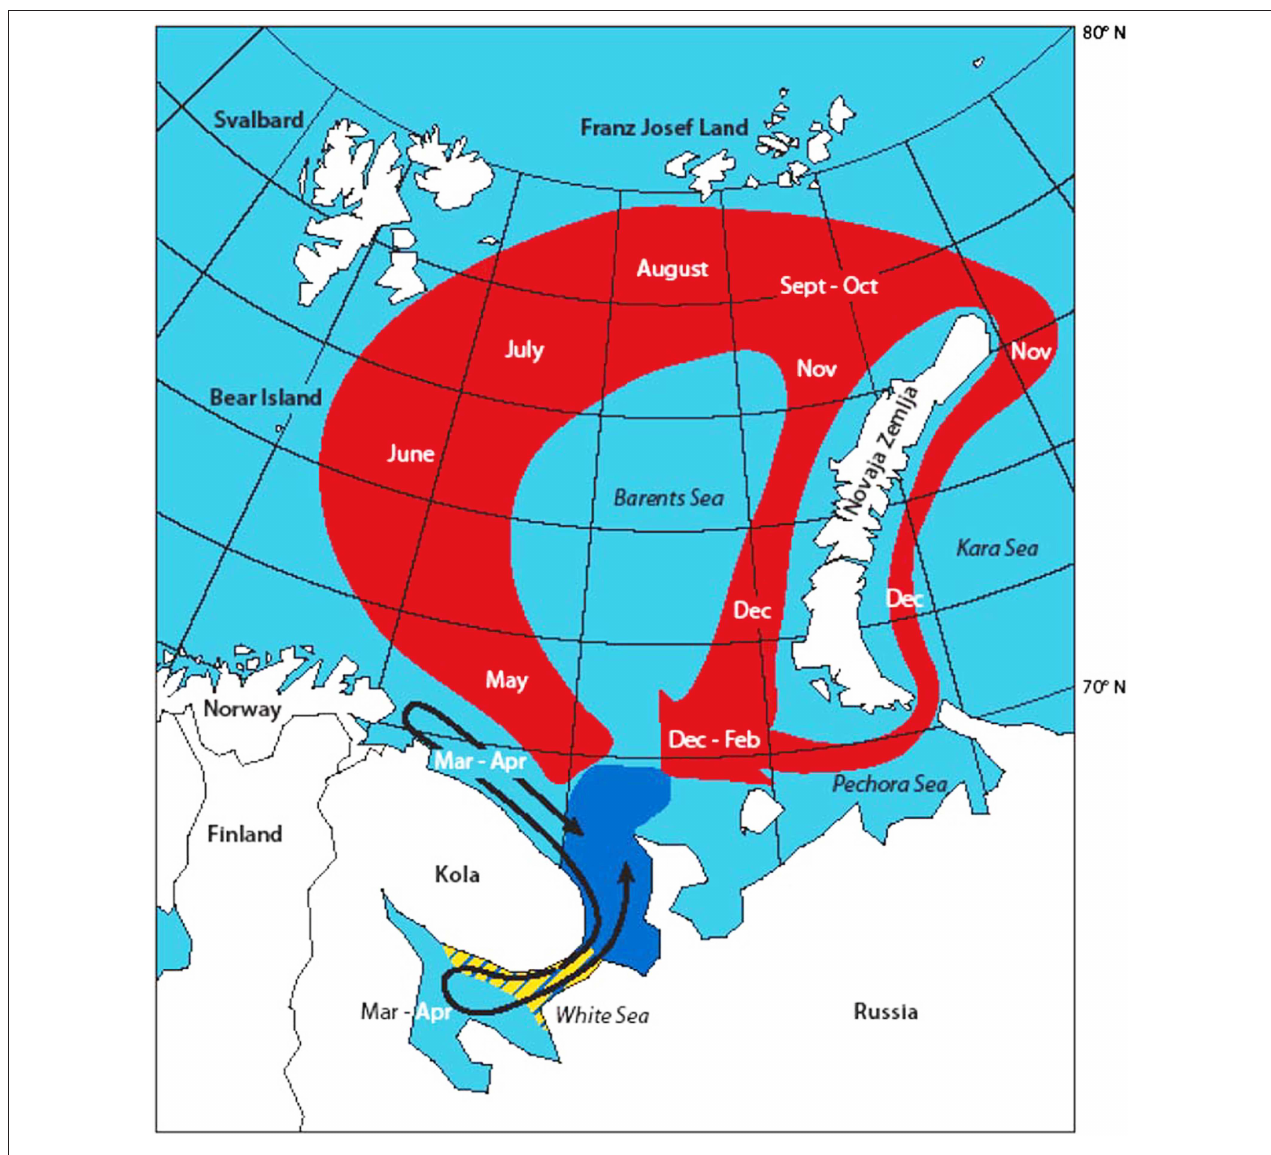
FIGURE 10 | Suggested gross annual migrations of the Barents Sea harp seal population between breeding in the White Sea in February-March and molting in May (black arrow), and between molting and breeding the following